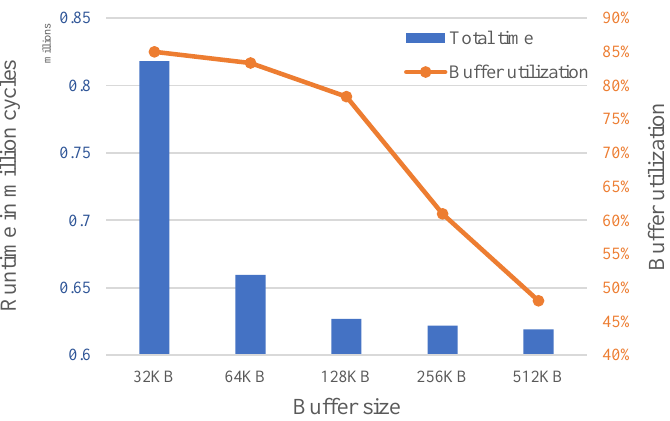
Figure 14. Optimal computation time and buffer utilization of convolution under different buffer sizes.